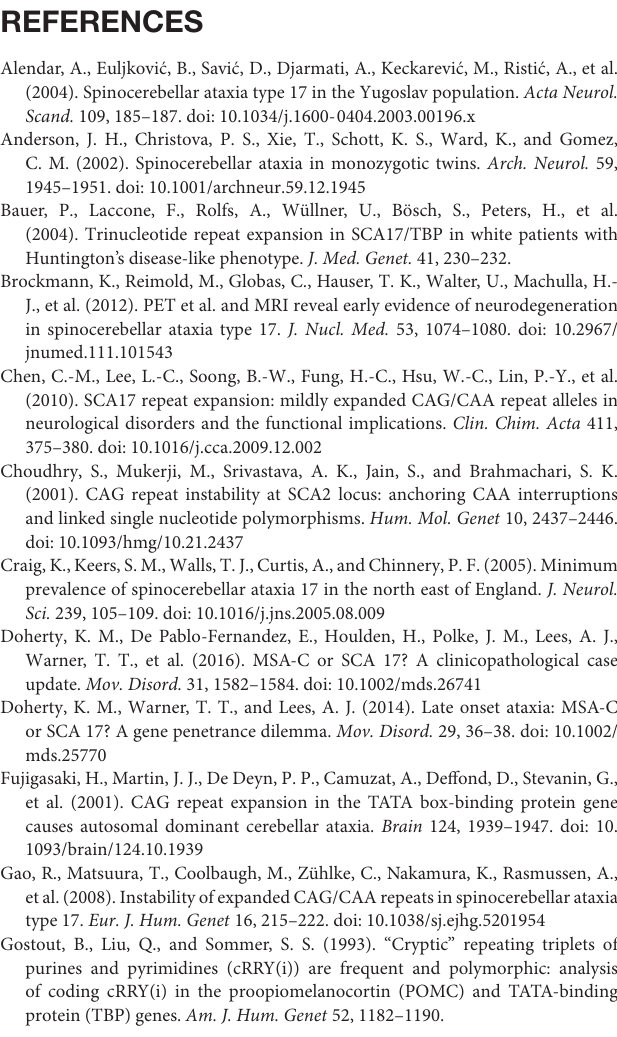
at disease onset data was available for 21 SCA17 patients that had been both analyzed by fragment sizing and clone sequencing and this data is plotted in red. If patients with 41 and 42 repeats are excluded from the analysis, only 9 patients remain, plotted in green. The bold line depicts the linear model fit result and the 95% confidence interval bounds are shown by the narrow line and shaded area. It is clear that the inclusion of the patients with 41 and 42 repeats improves the negative Pearson correlation ( r ) and the fit to the linear model ( R 2 ) with tighter confidence interval boundaries. TABLE S1 | Frequency with which each clone sequence was detected for each individual in our cohort. The bold lines indicate the variable penetrance range between 41 and 48 repeats. Domains 1–5 refer to the Domains I–V of the repeat structure as depicted in Figure 1 . 467 clones with 61 unique repeat region sequences were analyzed from 30 individuals with variable of fully penetrant SCA17 alleles. TABLE S2 | Frequency with which each clone sequence was detected for each individual in our cohort, corrected for the clone depth sequenced for each patient. The bold lines indicate the variable penetrance range between 41 and 48 repeats. Domains 1–5 refer to the Domains I–V of the repeat structure as depicted in Figure 1 . 467 clones with 61 unique repeat region sequences were analyzed from 30 individuals with variable of fully penetrant SCA17 alleles. The most frequent allele had 38 CAG/CAA repeats and was found in 47/467 clones (10%). All repeat configurations contained CAA interruptions.